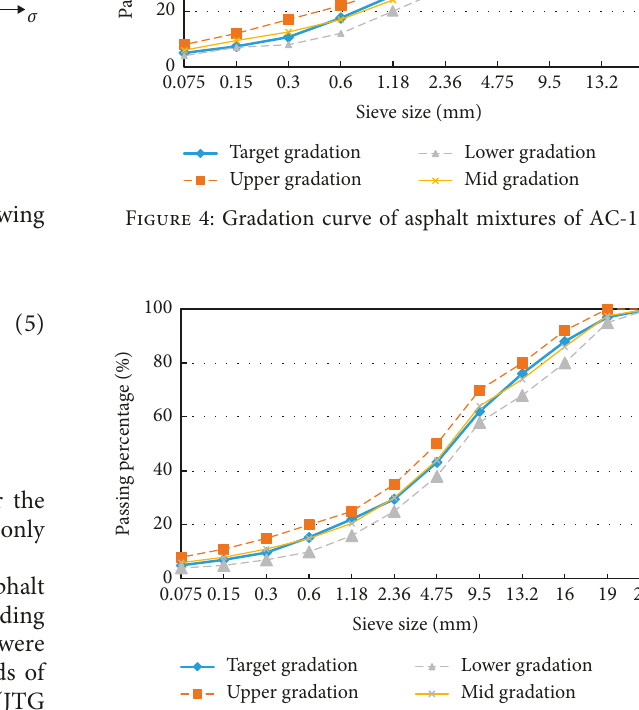
Figure 5: Gradation curve of asphalt mixtures of AC-20.